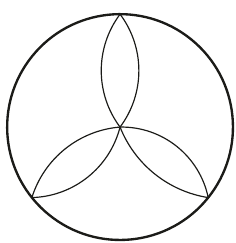
Figure 4. Clover diagram contributing to the expectation value of the latitude Wilson loop at 5